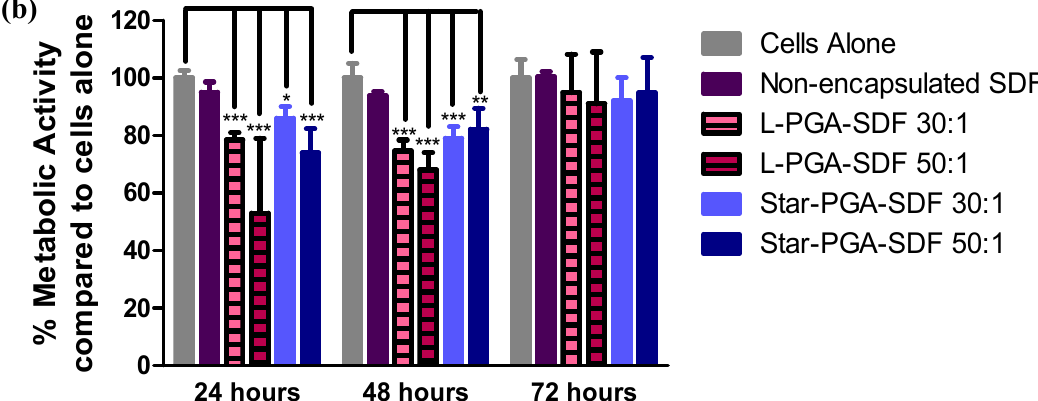
Figure 6. Biocompatibility of L-poly(glutamic acid) (PGA)—Stromal-Derived Factor 1 α (SDF) and star-PGA–SDF nanoparticles at PGA:SDF molar ratios of 30:1 and 50:1 containing 25 ng SDF ( a ) Live / Dead images of human umbilical vein endothelial cells (HUVECs) exposed to nanoparticle formulations for 24 or 72 h, Scale bar = 200 µ m. ( b ) metabolic activity of HUVECs exposed to the formulations listed for 24, 48 or 72 h measured using a MTS assay ( n = 3). * p < 0.05, ** p < 0.01, *** p < 0.001, compared to the metabolic activity of cells alone at the specific time point.